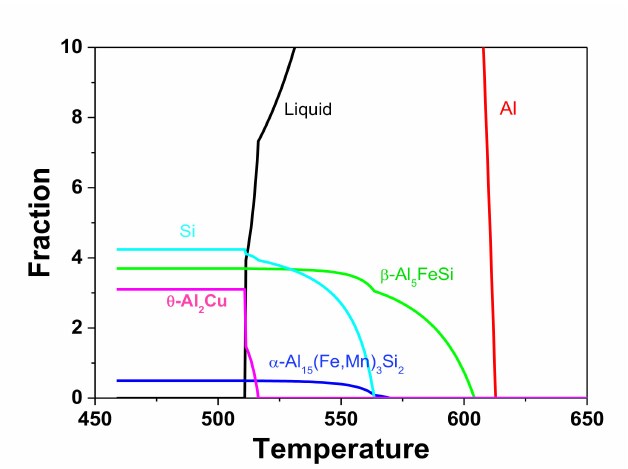
Figure 4. EPMA analysis of the as-cast Al6Si2Cu alloy (wt.%): ( a ) as-cast, ( b ) Al, ( c ) Cu, ( d ) Fe, ( e ) Mn, ( f ) Si.